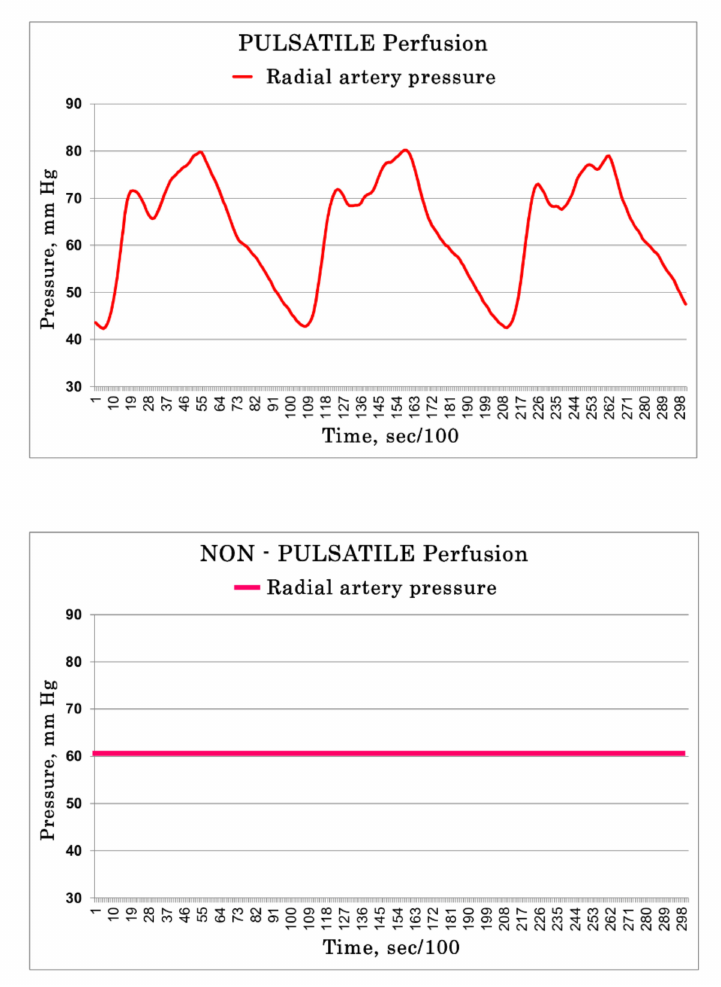
Figure 1. Examples of curve pressure over time in PP Group and in NP